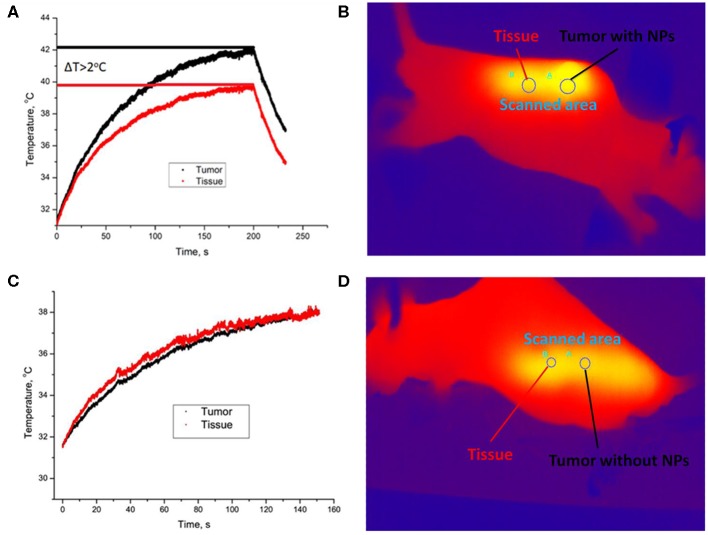
Temperature image of immunodeficient mice bearing a grafted A375 tumor during 975-nm laser irradiation at the intensity of 1 W/cm2. Melanoma xenograft labeled with UCNPs (A) and control (no UCNPs) (B). Area A is for tumor, and area B is for normal tissue. A temperature increase during laser treatment in the UCNP-labeled (C) and control (D) mice. The tumor (area A) is shown with a black curve, and normal tissue (area B) is visualized with a red curve.